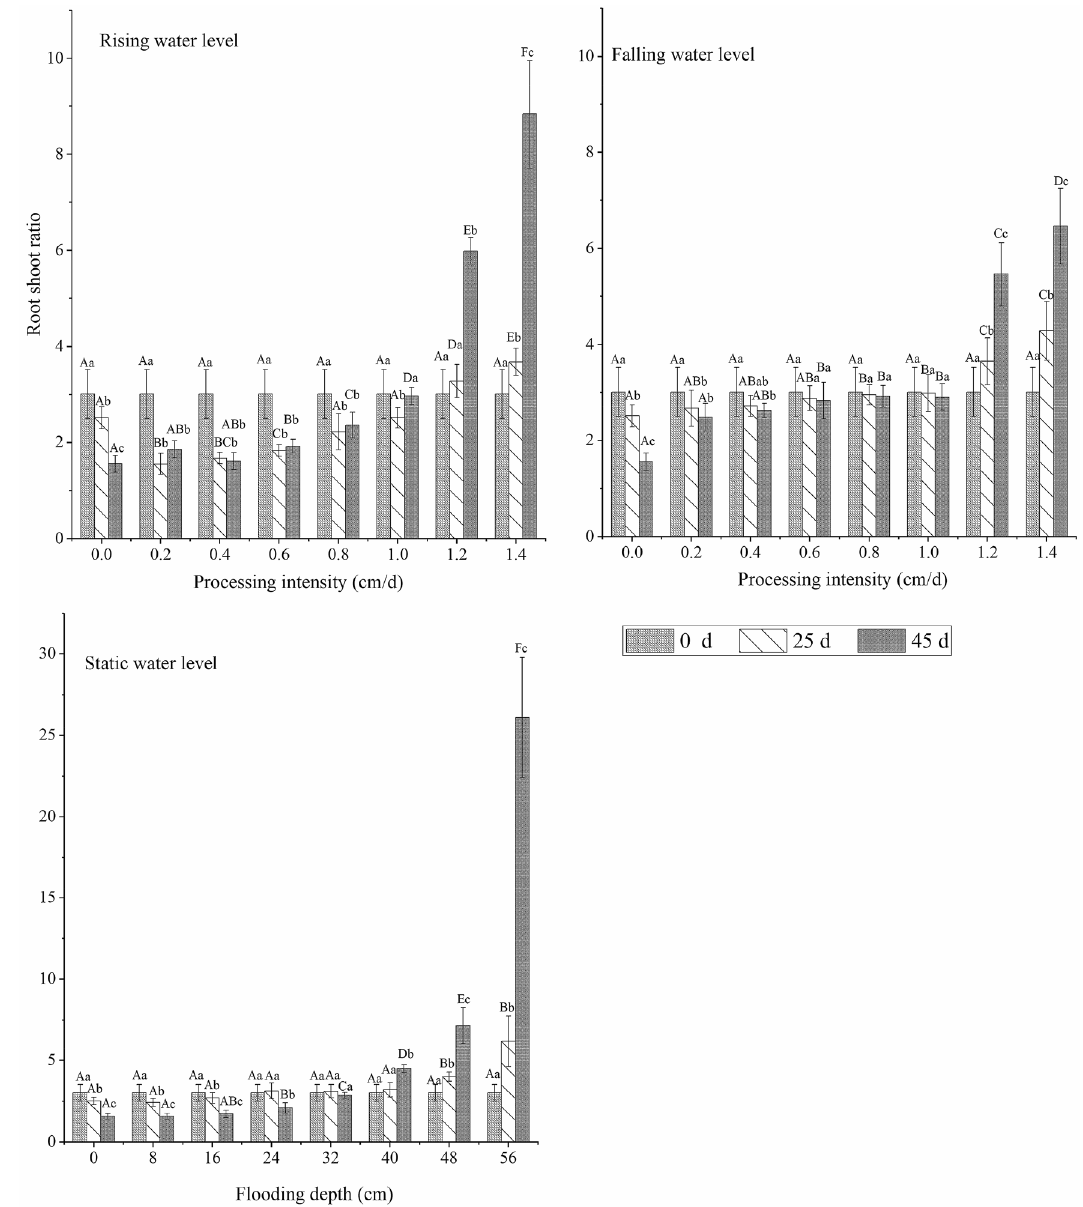
Figure 5. Effects of different hydrological environments on the root-to-shoot ratio of biomass and bioavailability of C.